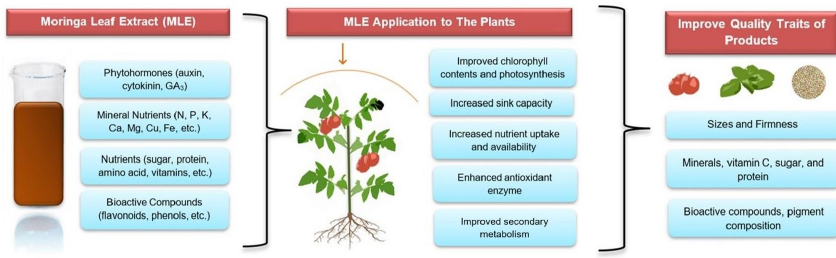
Figure 1. Mechanism of moringa leaf extract (MLE) in improving quality